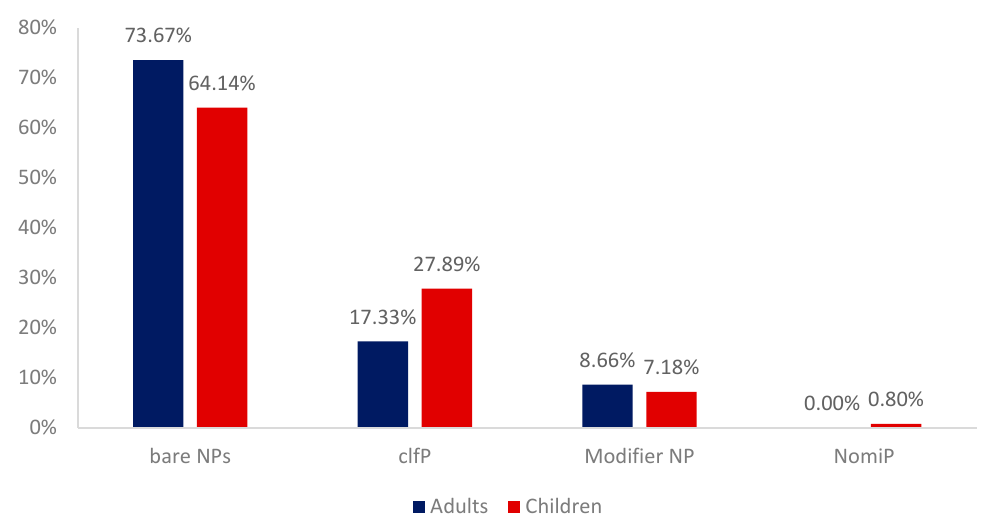
Figure 6. Mean proportions classifier NPs in conjunct NPs by IS in child and adult speech. (clfp = classifier phrase). 4. Discussion The current study investigated how labels for “old” and “new” referents are ordered in conjunct NPs in the speech of Mandarin-speaking adults and children: “old-before-new” or “new-before-old”. We conjectured that the two types of patterns reflect different aspects of the influence of conceptual prominence on word order, accessibility, and novelty. We asked if prior research demonstrating an “old-before-new” preference in adult language and a “new-before-old” preference in child language are language-independent preferences crosslinguistically, or whether these patterns could be modulated by the role of discourse-pragmatically motivated word order variations in the target language. Our results offer further evidence from Mandarin for the robust “old-before-new” word order preference in adult language: Mandarin-speaking adults produced the “old-before-new” order dominantly and consistently in the conjunct NPs, congruent with the “old-before-new” preference documented in adult speakers of German, English, and Arabic using a similar task of elicited